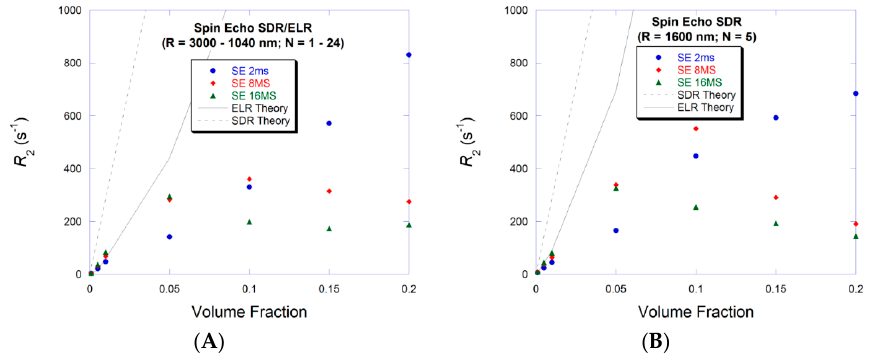
Figure 9. R 2 values are plotted vs. particle volume fraction for particles within MAR. ( A ) The particle size is increased while the radius is decreased to achieve increasing volume fraction; ( B ) The particle size and radius are kept constant while the sample space is decreased to achieve increasing volume fraction. ELR R 2 theory overestimates R 2 simulated values.